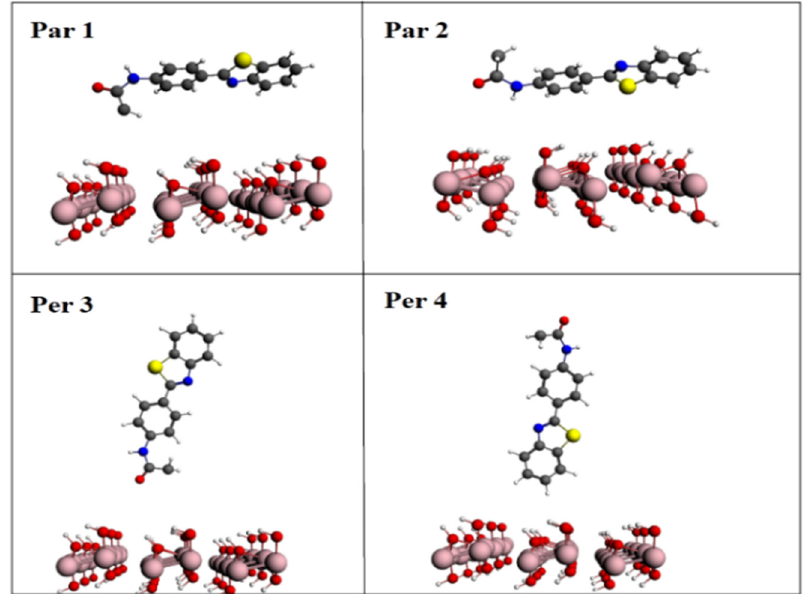
Figure 5. Schematic view of the derivative ABT interacting with the feroxyhyte surface in four arrangements: Par1 : the functional group interacts in parallel with the surface; Par2 : the functional group interacts in parallel with the surface; Per3 : the ABT functional group interacts perpendicularly with the surface; Per4 : the ABT functional group interacts perpendicularly with the surface.